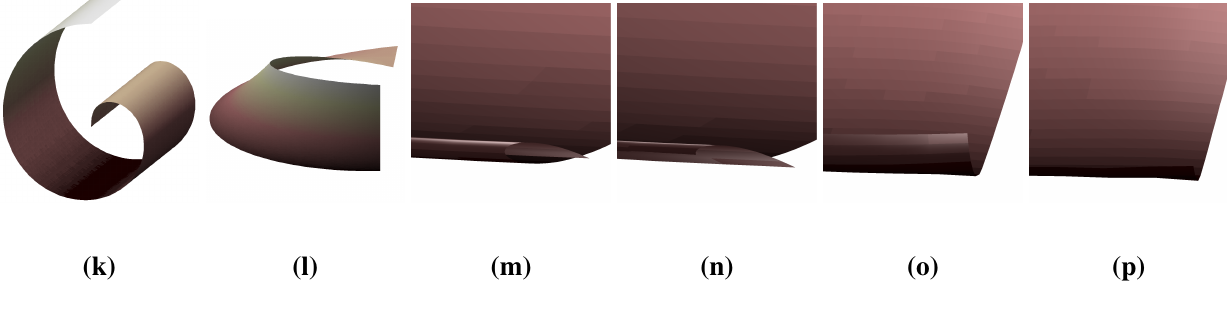
Figure 7. Surface morphing between a spiral-generated surface and part of a Mobius strip. ( a , b ) The spiral-generated surface and Mobius strip part, respectively. ( c , e ) The 25th morphing sequence using linear interpolation and our proposed morphing algorithm, respectively. ( d , f ) The 26th morphing sequence using linear interpolation and our proposed morphing algorithm, respectively. The surface intersection occurs in the linear interpolation method.